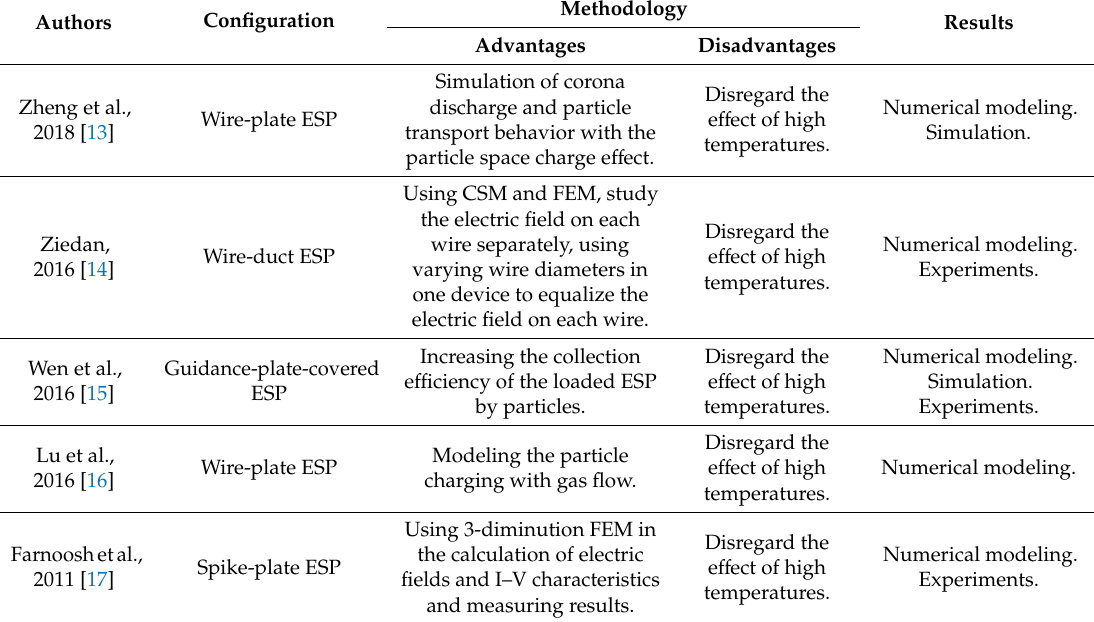
Table 1. Summary of the literature review of the modeling of wire-duct electrostatic precipitators